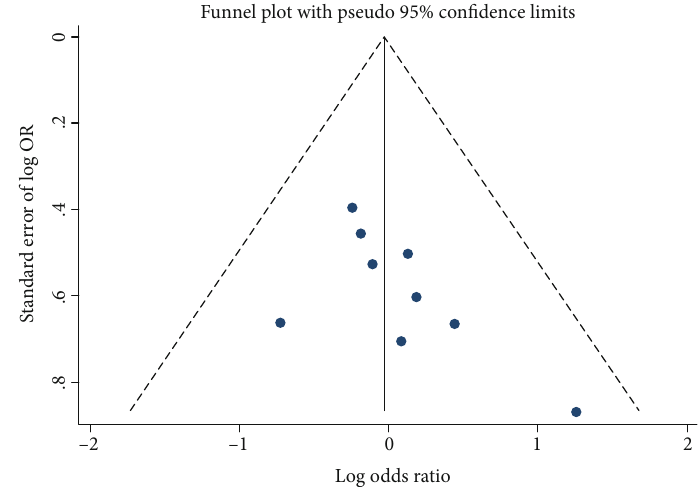
Figure 8: Funnel plot of circRNAs for esophageal